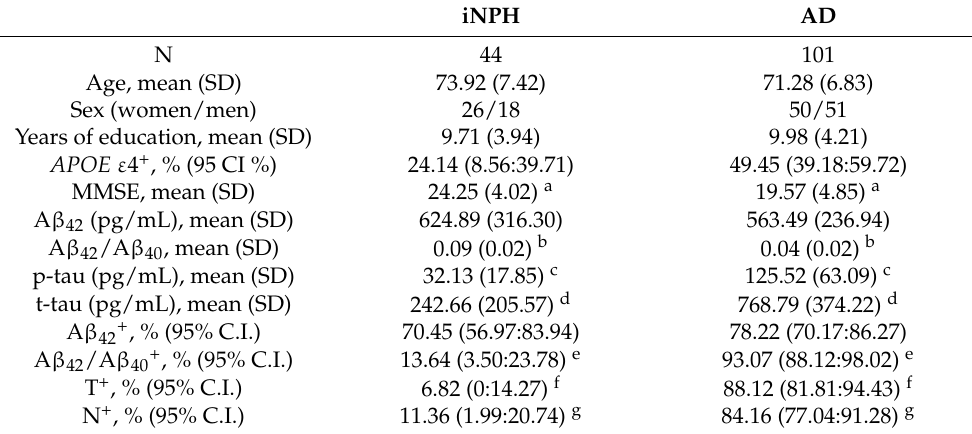
Table 1. Comparison of demographic variables and CSF biomarker values between iNPH and AD patients.